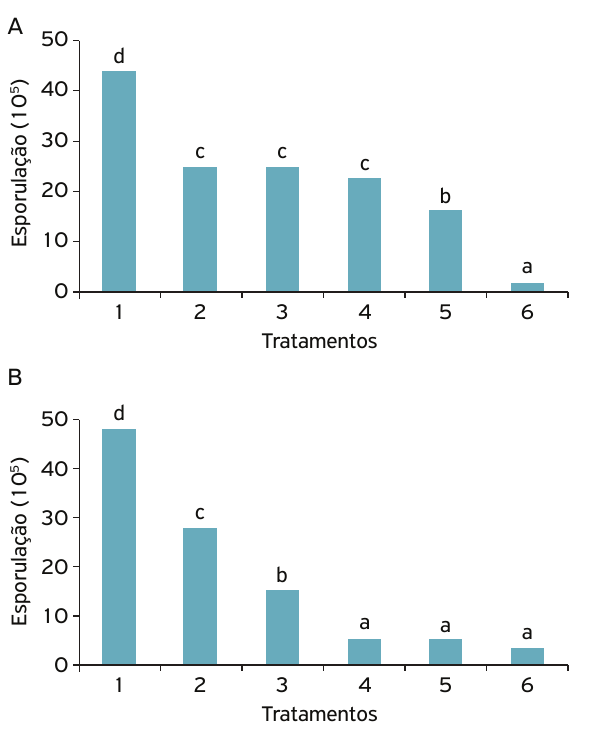
Figura 1. Efeito do óleo de café verde misturado ao meio de cultura (contato direto) na redução da esporulação de Penicillium roqueforti (A) e Rhizopus stolonifer (B). Tratamentos: 1) controle; 2) óleo de café verde (OC) 500 μ L L -1 ; 3) OC 1.000 μ L L -1 ; 4) OC 1.500 μ L L -1 ; 5) OC 2.000 μ L L -1 ; 6) óleo essencial de cravo-da-índia 800 μ L L -1 . Letras distintas representam diferença significativa entre os tratamentos pelo teste de Scott-Knott a 5% de